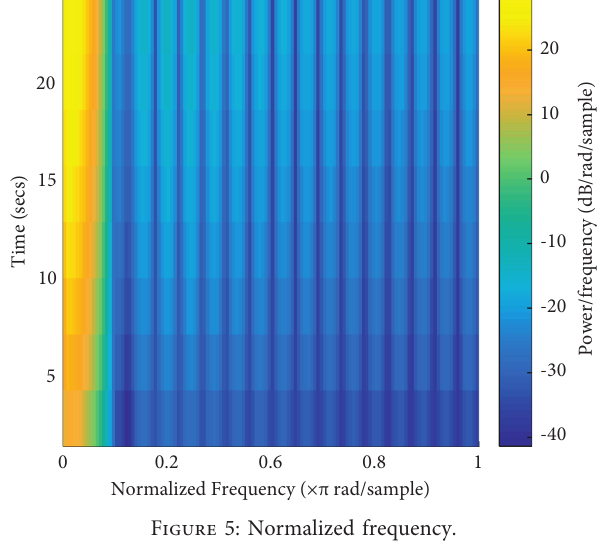
Figure 5: Normalized frequency.